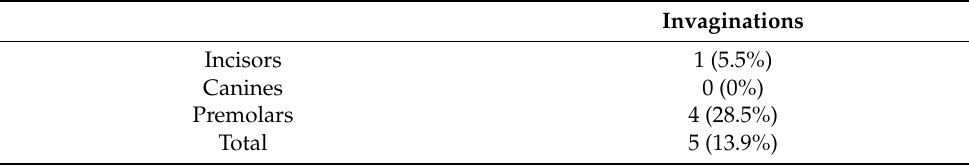
Table 2. Distribution of invaginations by